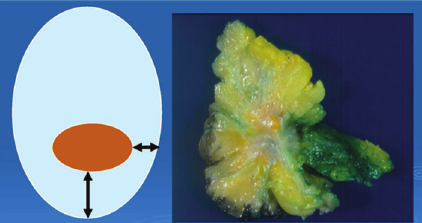
Figure 4: On left, gross inspection in theory: A clearly defined mass measurable from the margins. On right: Reality, an ill-defined mass with indistinct borders and irregular specimen edges.